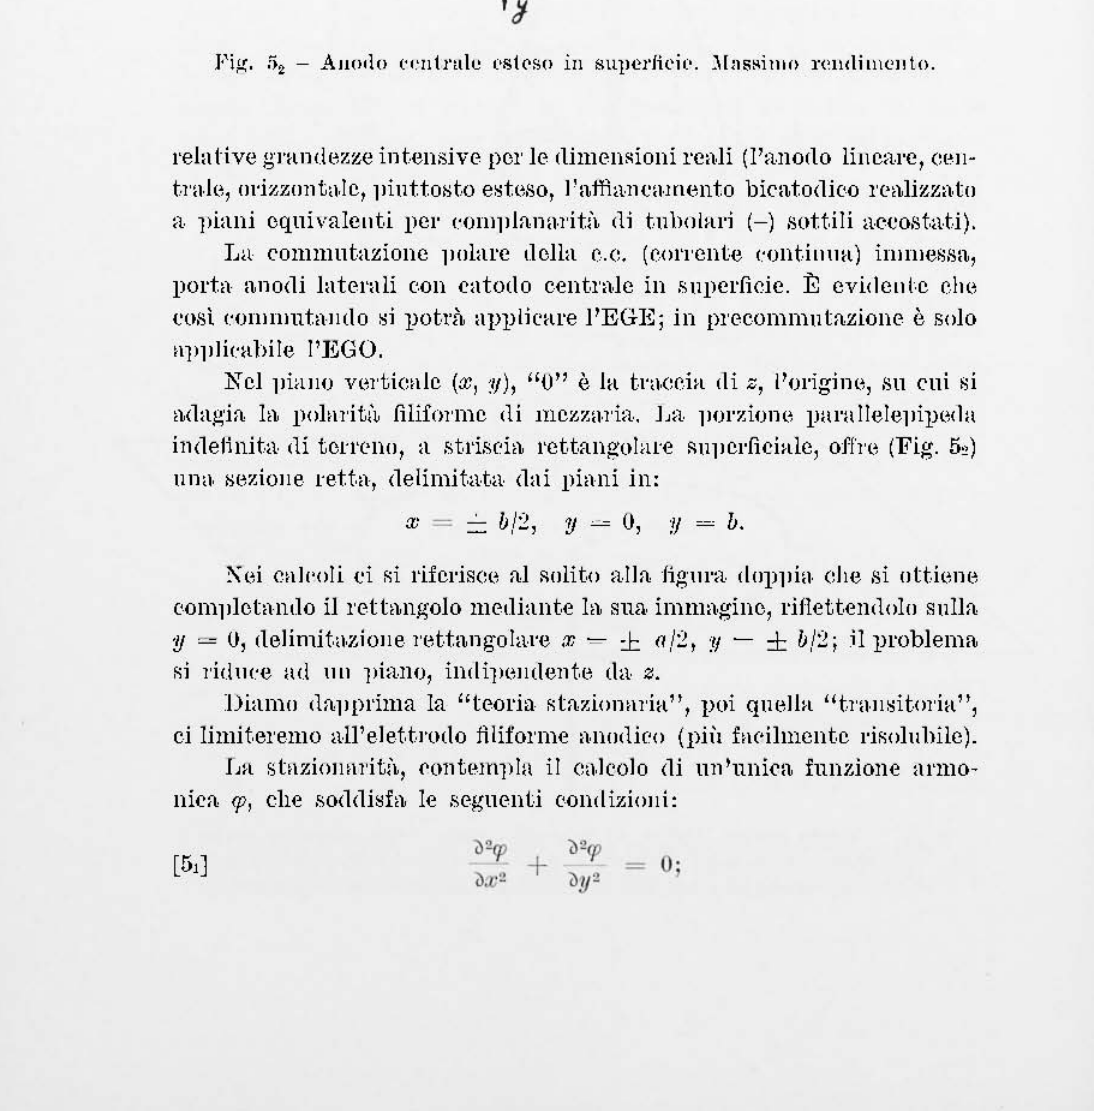
Fig-. "2 - AlIo,lo (' .. nlmle ('81(,80 in sllpel'liei(' . .:I[:ls~illlO